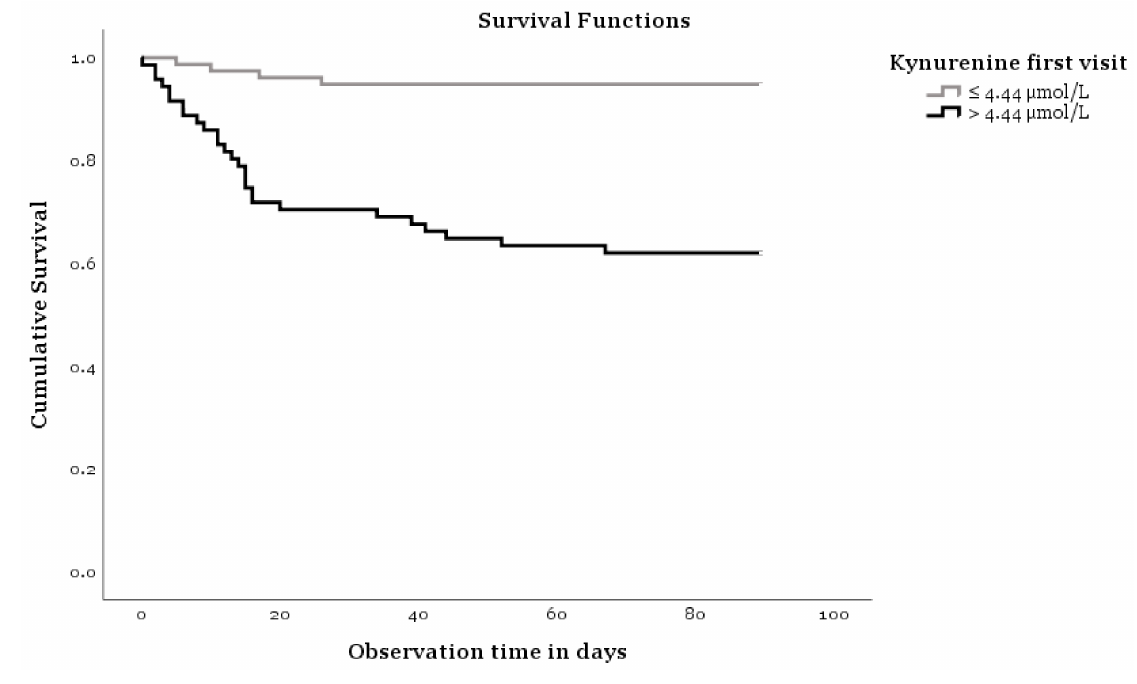
Figure 1. Kaplan-Meier analysis. Table 3. Results of the